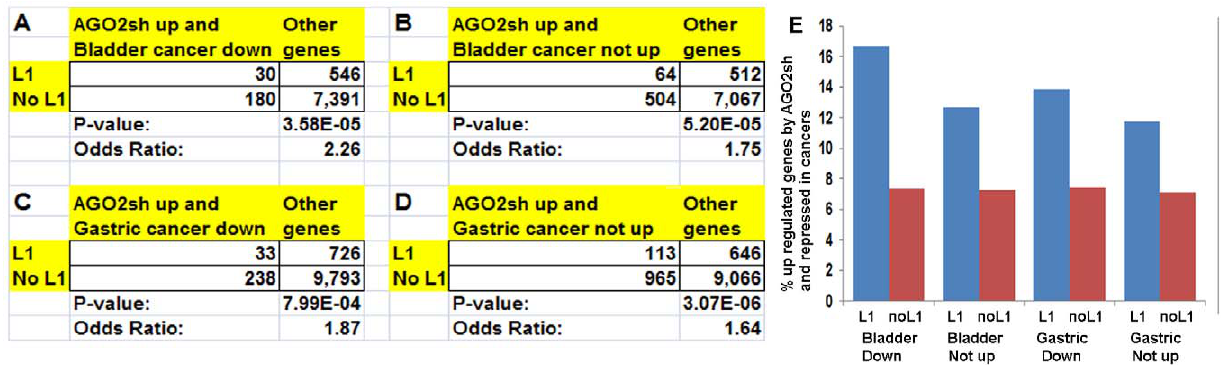
Figure 7. AGO2 represses expression of gene containing L1 in cancer. The chi-square test shows that the up-regulated genes in AGO2si and the down-regulated (or not up) genes in A) and B) bladder carcinoma and C) and D) gastric carcinoma are associated with L1. The test and control datasets are the same as present in the Supporting Table S3.12, S3.7 and S3.8. E) The percentage of genes that was both up-regulated by AGO2sh and repressed in cancer cells.